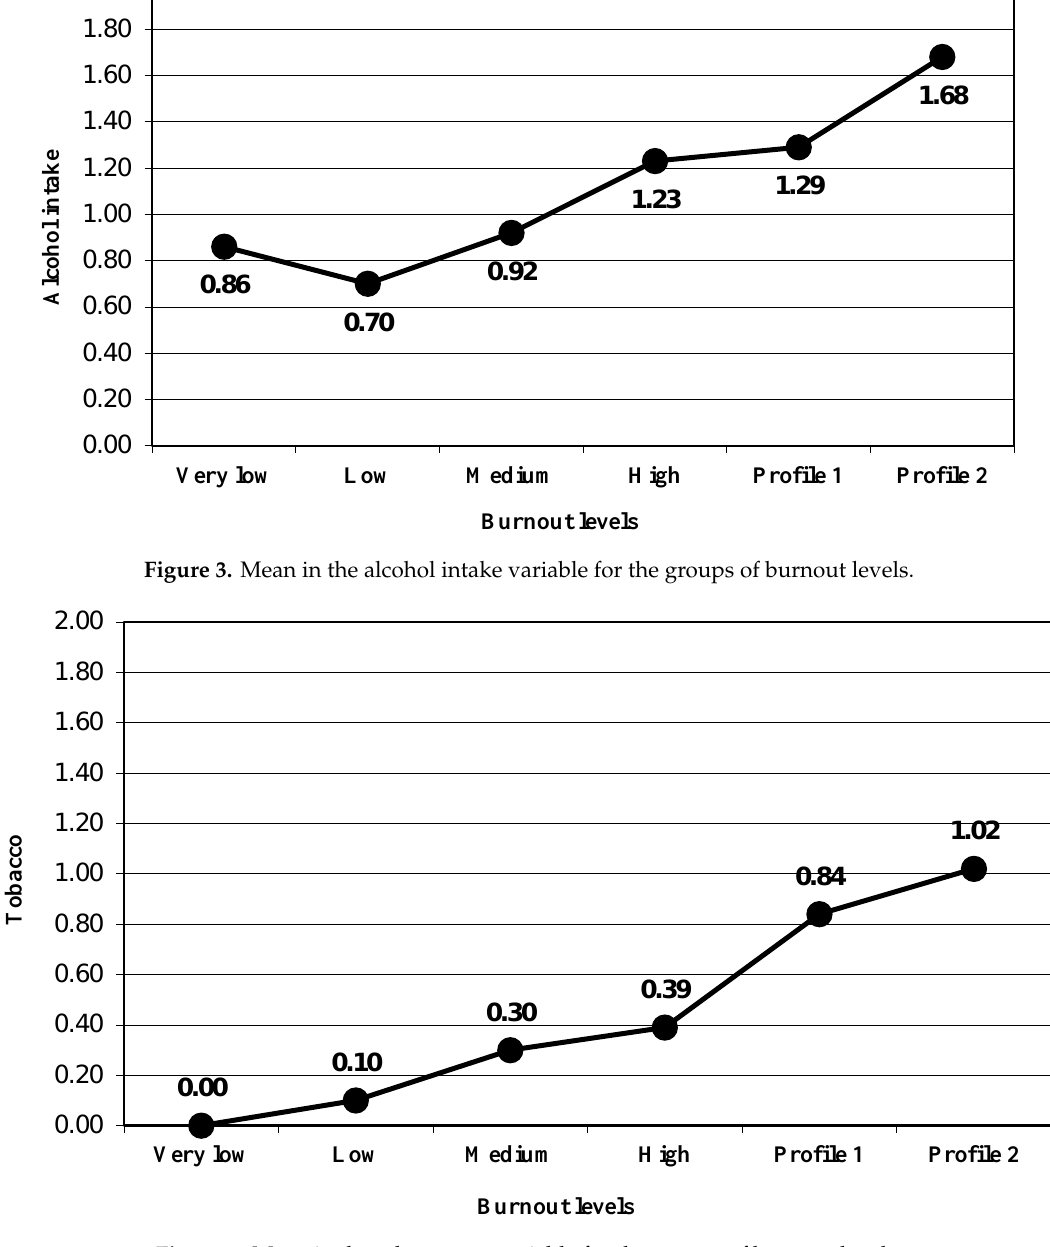
Figure 4. Mean in the tobacco use variable for the groups of burnout levels.